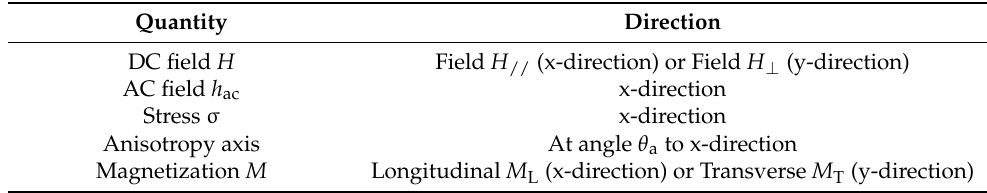
Table 1. Physical quantity of the